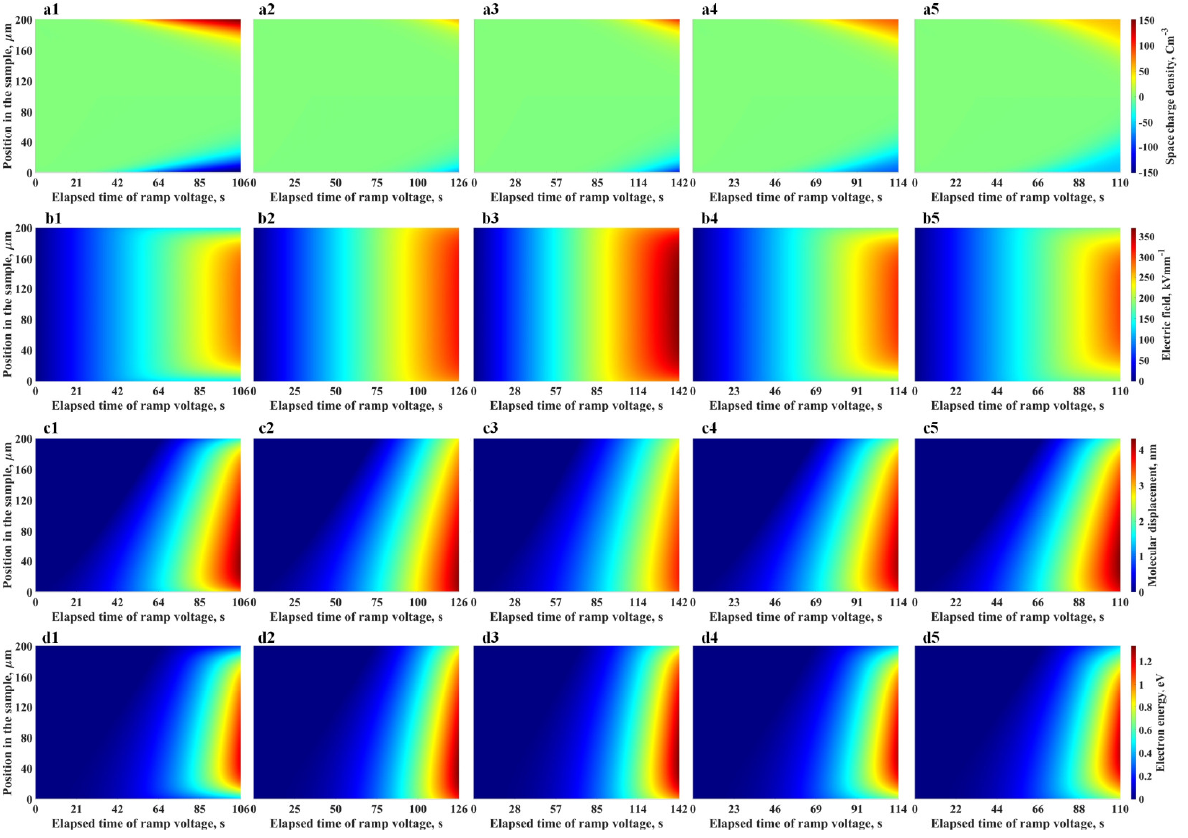
Figure 6. Distributions of space charges ( a1 – a5 ), electric fields ( b1 – b5 ), molecular displacements ( c1 – c5 ), and electron energy gains ( d1 – d5 ) in pure LDPE and LDPE/Al 2 O 3 nanocomposites with nanofiller contents of 0.1 wt%, 0.5 wt%, 2.0 wt%, and 5.0 wt%.